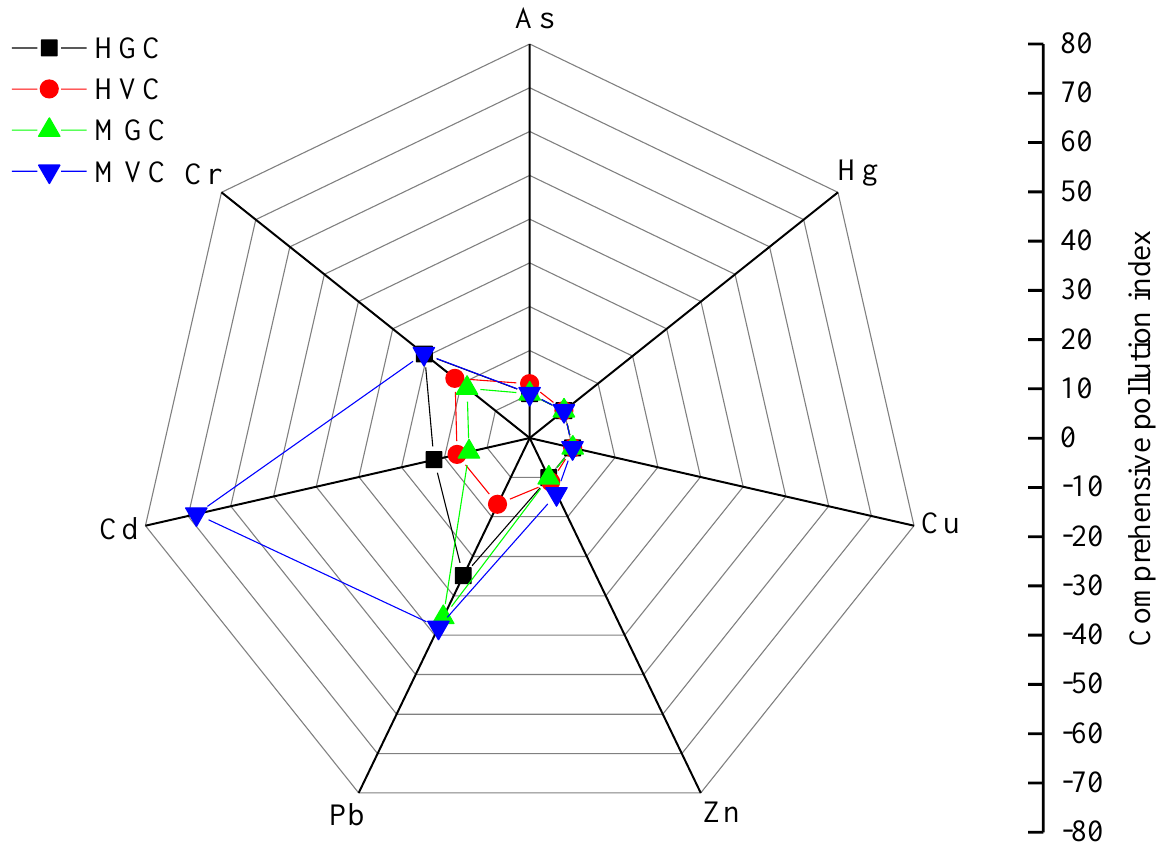
Figure 3. Crop comprehensive pollution index in different pollution types. Note: HGC represents the crop of the grain field in the high geological background area; HVC represents the crop of the vegetable field in the high geological background area; MGC represents the crop of the grain field in the superimposed area of the high geological background and mining activities; MVC represents the crop of the vegetable field in the area where the high geological background and mining activity overlap.